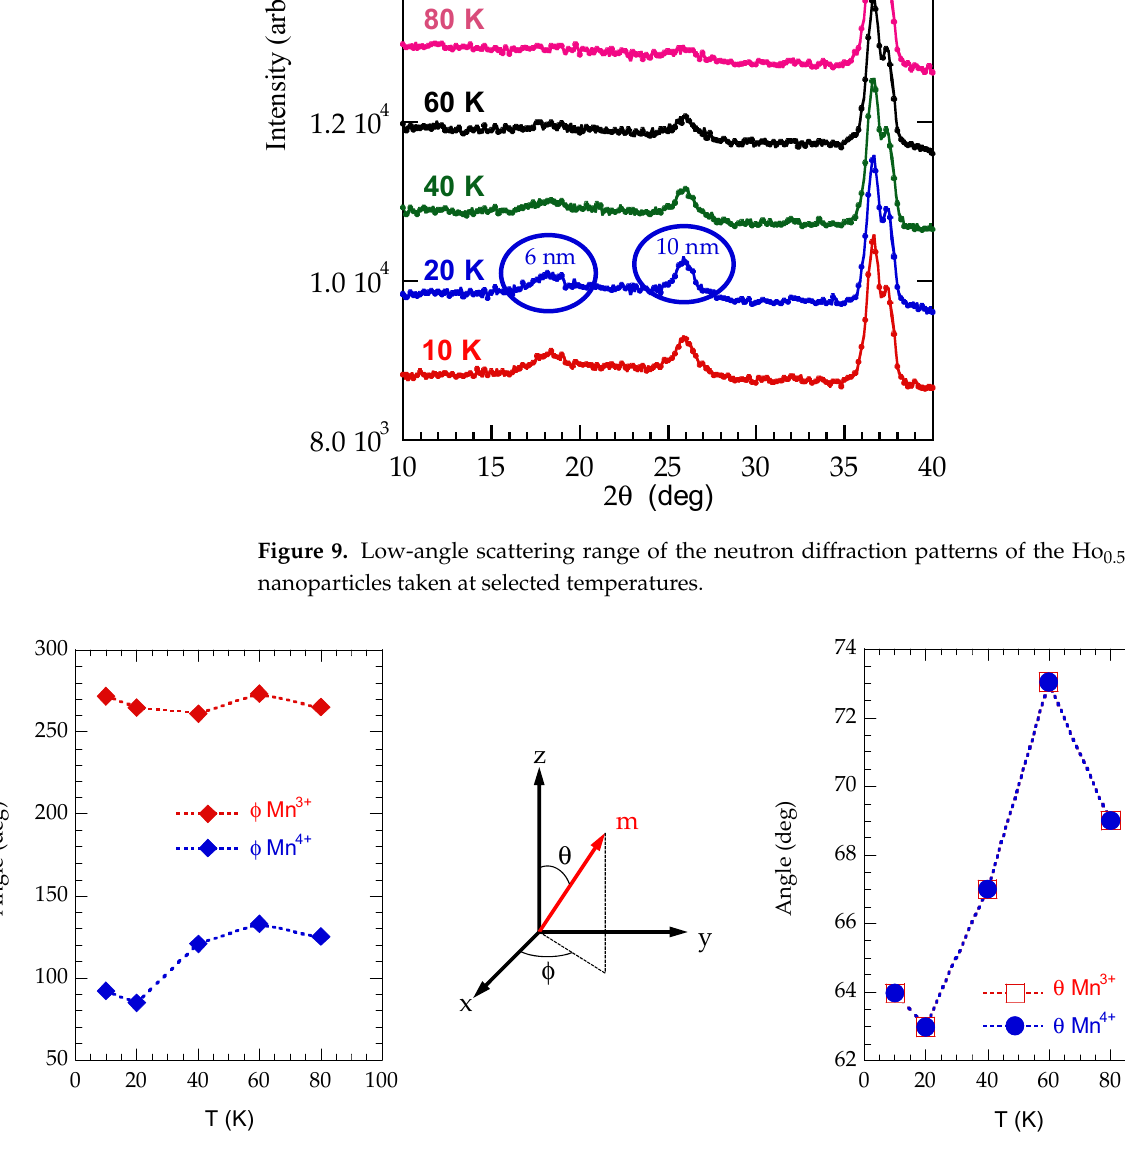
Figure 10. Spherical coordinates representation of the magnetic moment m of formally Mn 3+ and Mn 4+ ions, relative to the x-y-z axes of the Pbnm cell, as obtained by the neutron diffraction patterns of the nanoparticles refined with a single nuclear Pbnm phase and a single 2a × 2b × c magnetic supercell.